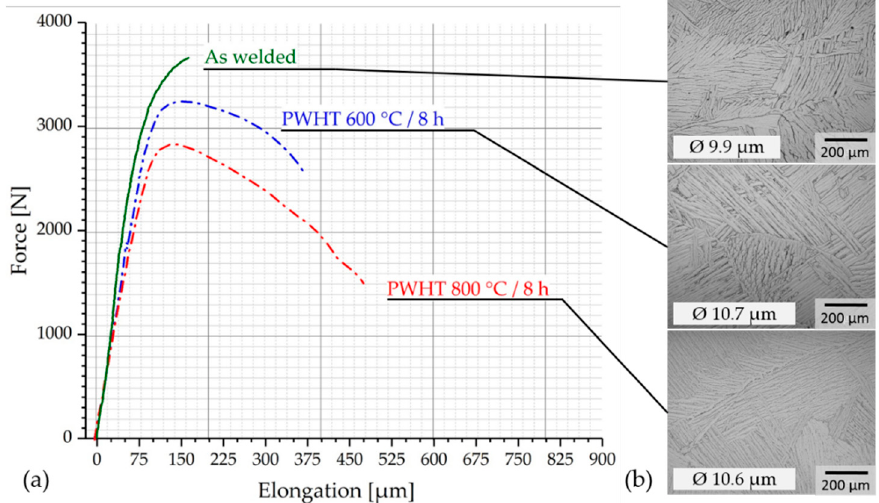
Figure 6. Material spectrum of the base material analyzed with EDX.